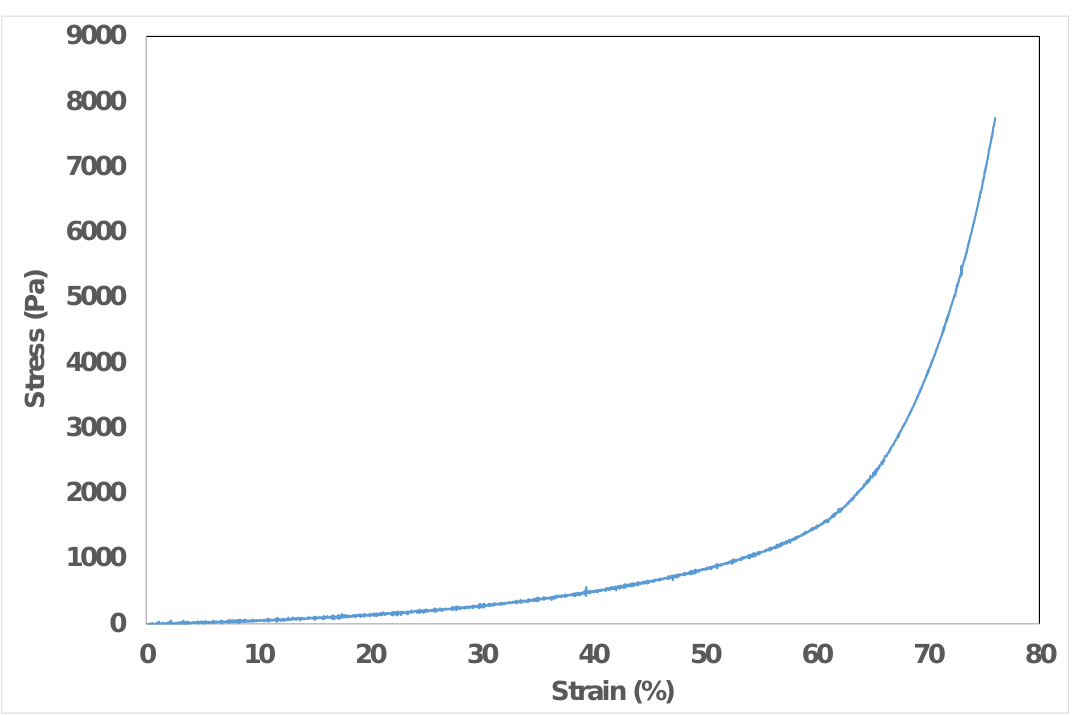
Figure 7 . The compression stress-strain curve of cryogel (sample 2). Figure 7. The compression stress-strain curve of cryogel (sample